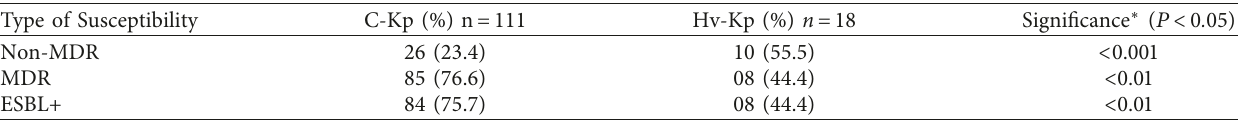
Table 5: Comparison of antibiotic susceptibility patterns of classical Klebsiella pneumoniae (C-Kp) and hypervirulent Klebsiella pneumoniae (Hv-Kp).